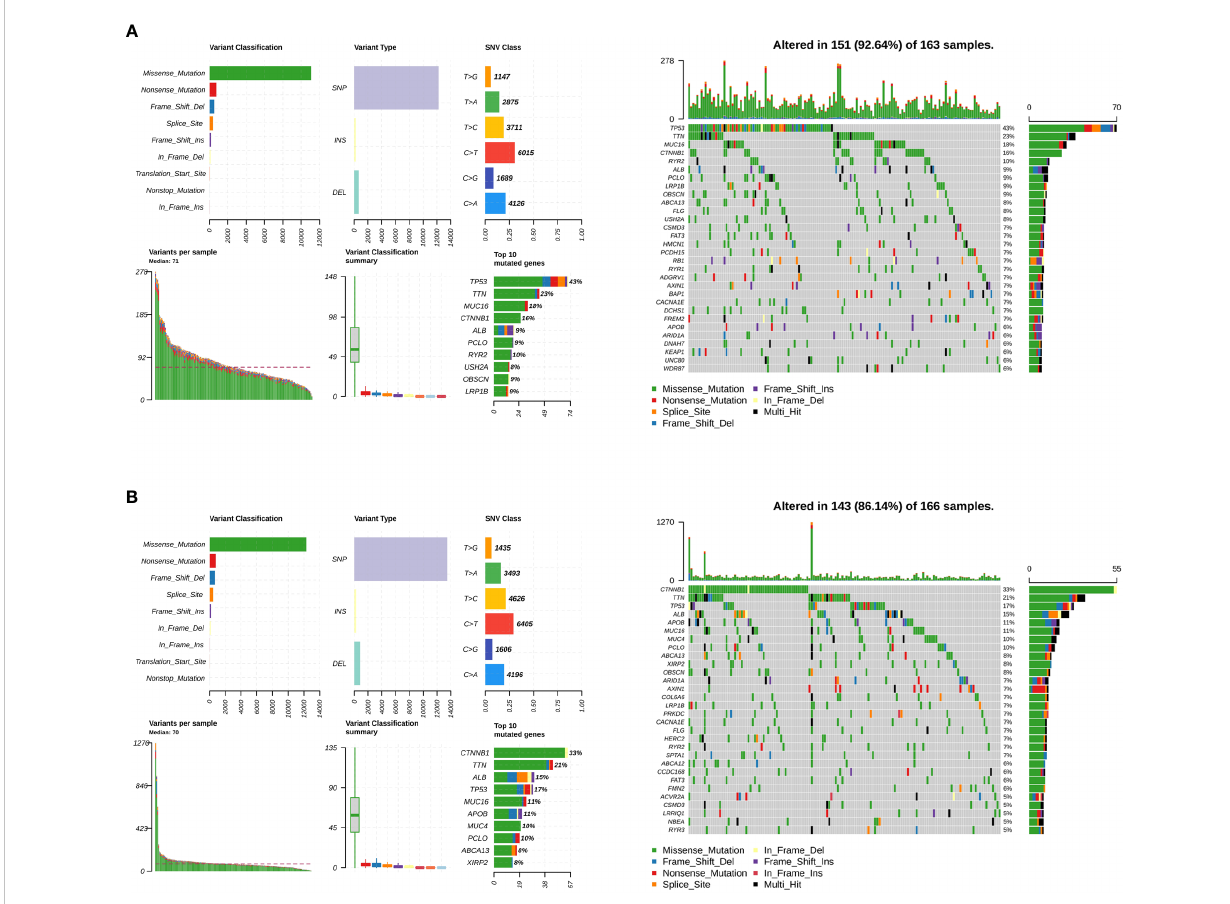
FIGURE 6 The tumor mutation burden characteristics of patients in the LMRG high- and low-risk groups. (A) Mutational landscape in the TCGA cohort of the LMRG high-risk groups. (B) Mutational landscape in the TCGA cohort of the low-risk